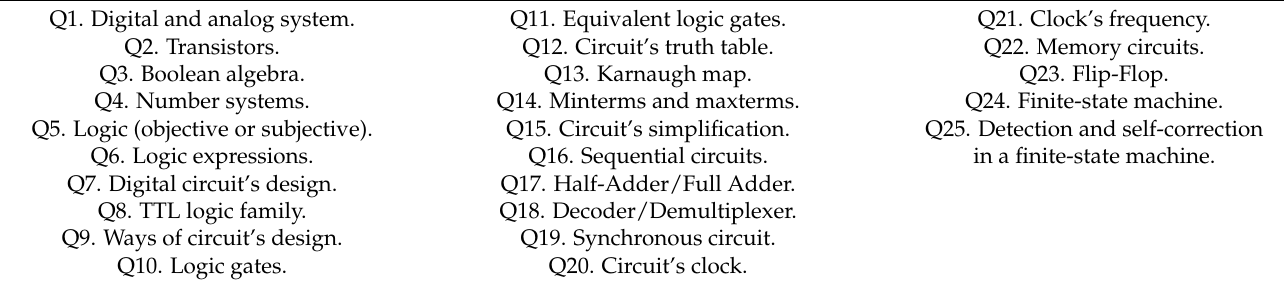
Table 1. Cognitive